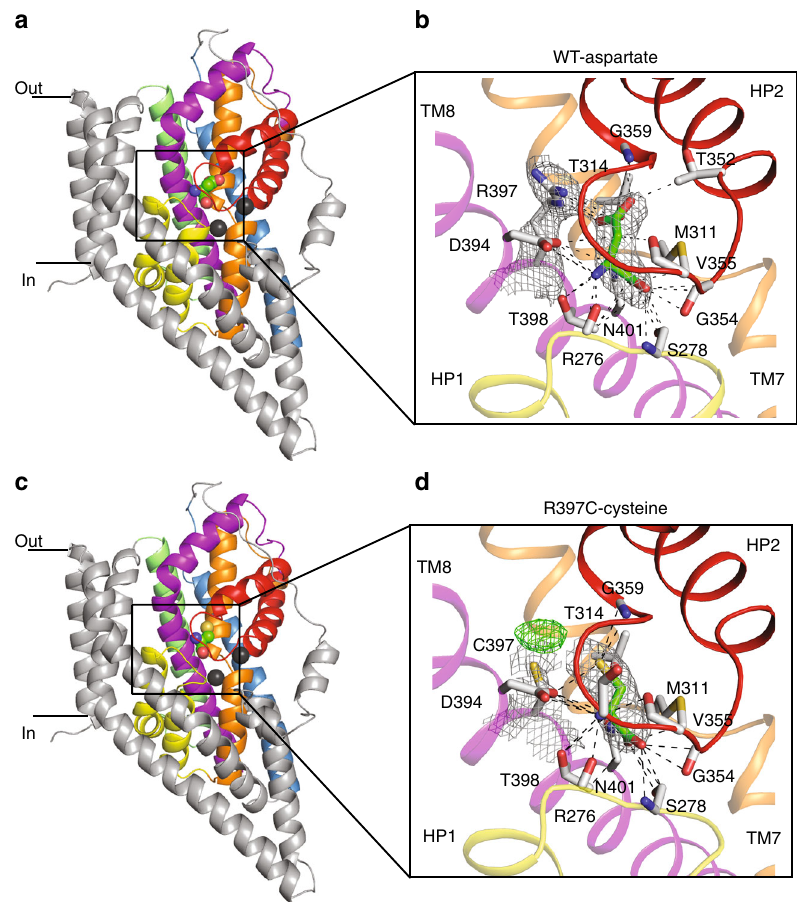
Fig. 5 Substrate-binding site in wild-type and mutant Glt Ph View of a single protomer of the wild-type Glt Ph bound to L-Aspartate a and Glt Ph -R397C bound to L-Cysteine c . The protomer is divided into the ‘ scaffold domain ’ (TM1, TM2, TM4 and TM5, coloured in grey) and the ‘ transport domain ’ (TM3 in blue, TM6 in green, TM7 in orange, TM8 in magenta, HP1 in yellow and HP2 in red). Bound substrate is shown in stick representation and Na1 and Na2 are shown as dark grey spheres. Close-up view of the L-Aspartate b and the L-Cysteine d binding sites, respectively. Interactions within 3.5 Å between bound substrate and residues in the Glt Ph -binding site are shown as dashed lines. Averaged 2fo – fc electron density maps at 1 σ are shown in dark grey mesh and averaged fo – fc electron density maps at 3 σ sigma are shown in